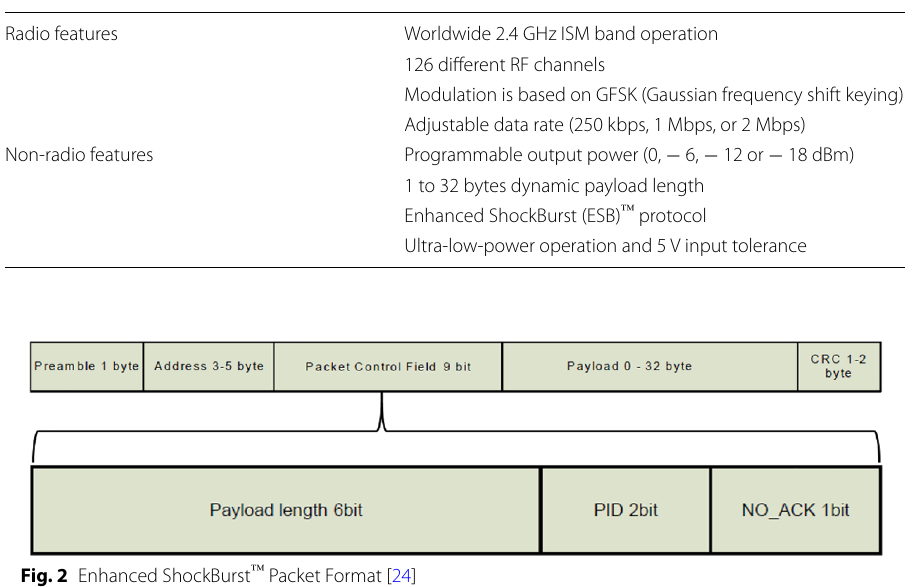
Table 1 nRF24L01 Radio